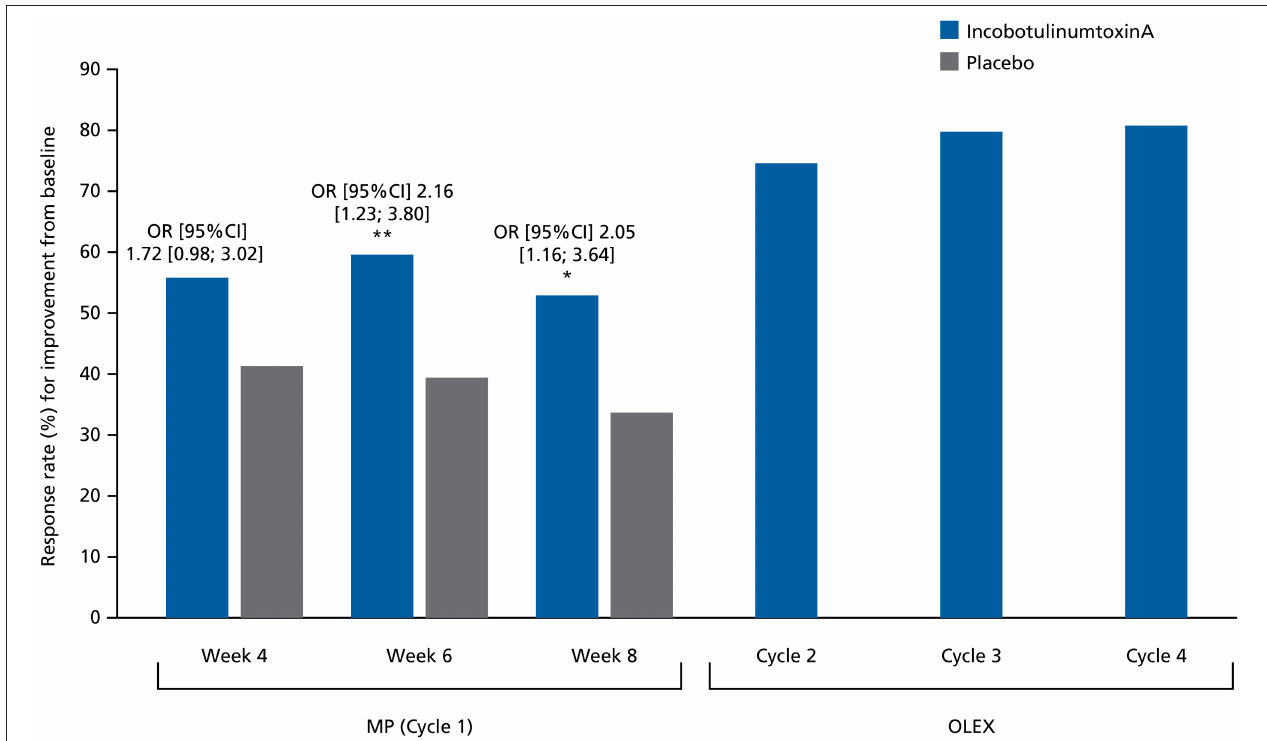
FIGURE 4 | Response rates (%) for at least 1-point improvement from baseline in MAS-PF at Weeks 4, 6, and 8 in the MP and at the Week 4 assessment visit during Cycles 2, 3, and 4 in the OLEX (worst-case approach, FAS). Comparisons between treatment groups were performed using a logistic regression model where response to treatment was the dependent variable, baseline MAS-PF score was a covariate, and site (pooled), treatment and sex were factors. CI, confidence interval; FAS, full analysis set; MAS-PF, Modified Ashworth Scale spasticity score for the plantar flexors; MP, main period; OLEX, open-label extension period; OR, odds ratio. * p < 0.05. ** p <